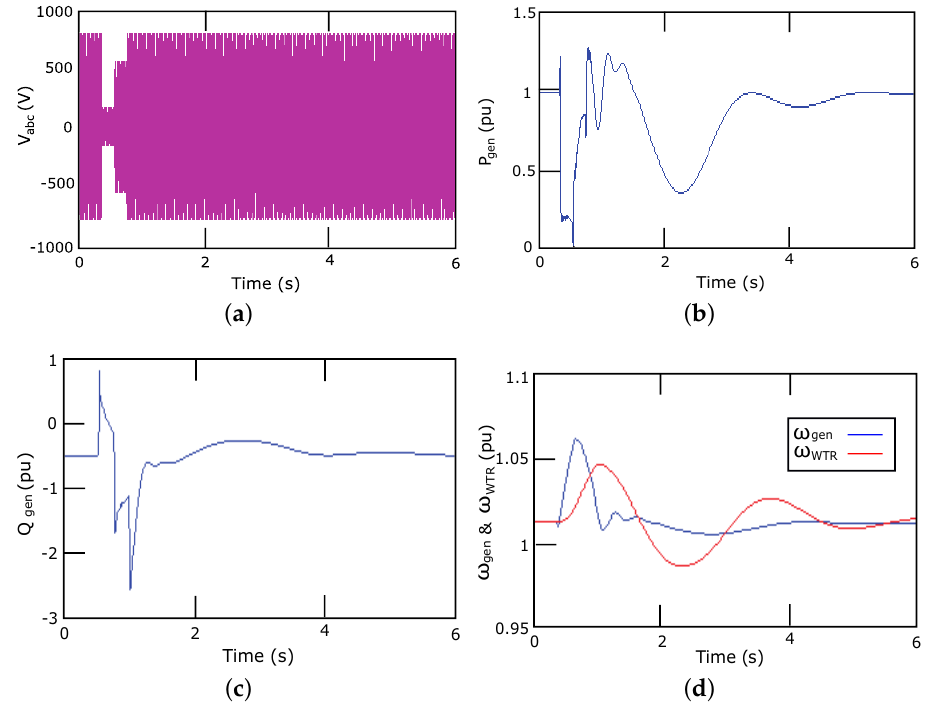
Figure 19. Response of Type 1B WT ( a ) Voltage dip ( b ) Generator active power ( c ) Generator reactive power ( d ) Generator and turbine rotational